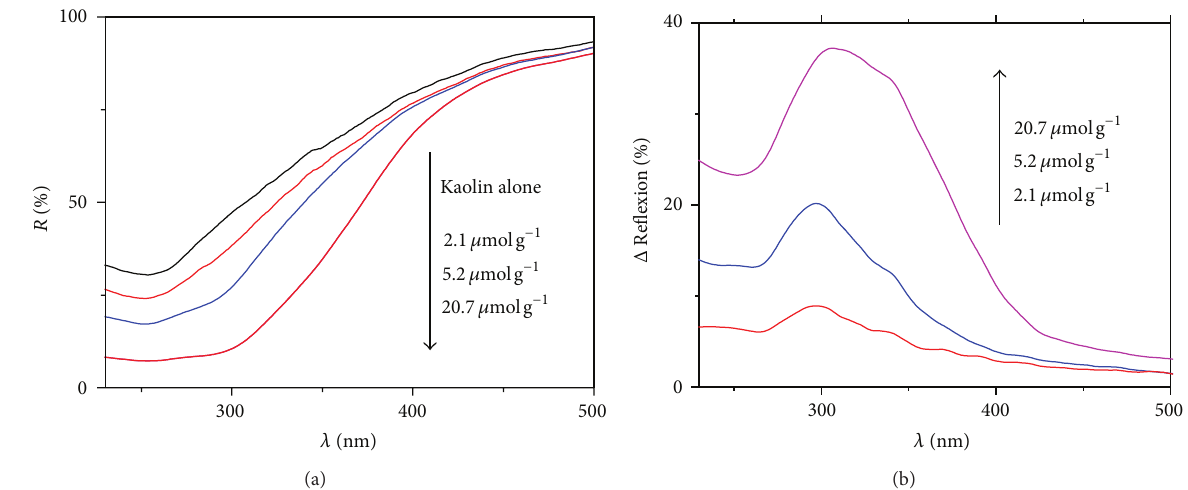
Figure 1: (a) Diffuse reflectance of mesotrione at the surface of Kaolinite as a function of concentration. (b) The reflection spectrum owing to the organic compound mesotrione. Film thickness: 200 𝜇 m.